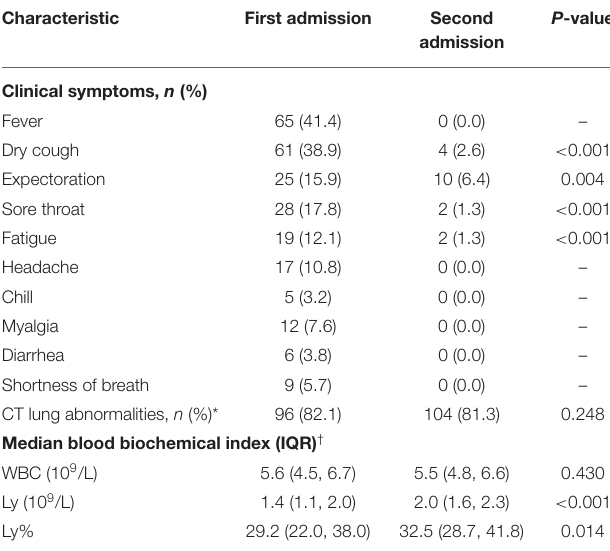
TABLE 2 | Characteristic of 157 repositive patients at first and second